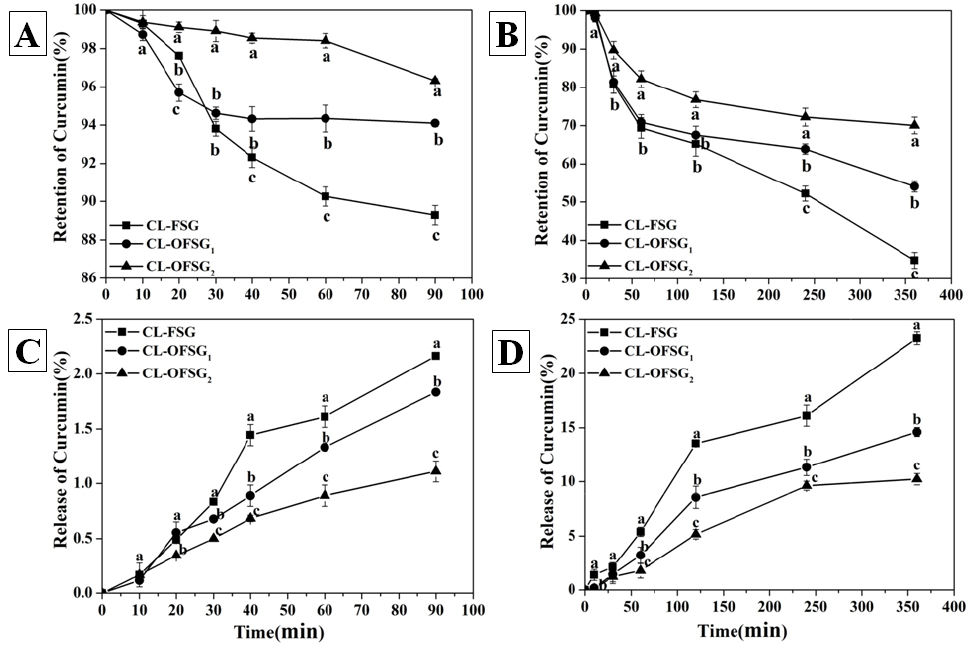
Figure 5. In vitro simulated gastric ( A , C ) and intestinal ( B , D ) stability and the release of curcumin- loaded fish scale gelatin (CL-FSG) and octenylsuccinate fish scale gelatin (CL-OFSG 1 , degree of substitution = 0.026; CL-OFSG 2 , degree of substitution = 0.107). Values bearing different superscript lowercase letters at the same time are significantly different ( p < 0.05).